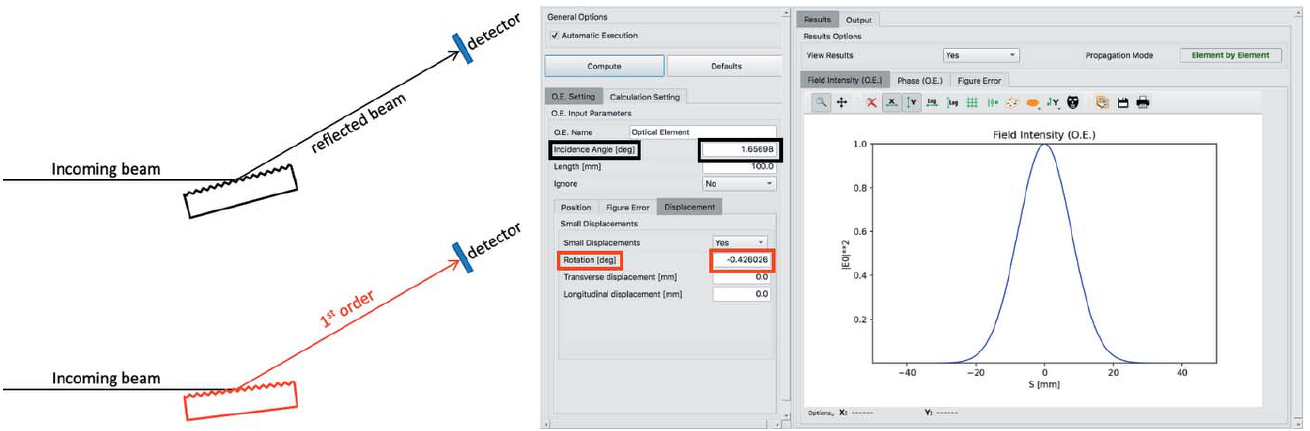
Figure 4 The ‘workaround’ process starts by defining the proper position/direction of the beam and the detector by ‘telling’ WISER that the element is a mirror (top left image), and setting the angle of incidence (black rectangles in the right image). Then a rotation is applied to the optical element (red rectangles in the right image) to have the required angle of incidence on the grating to diffract the beam in the detector direction (lower left